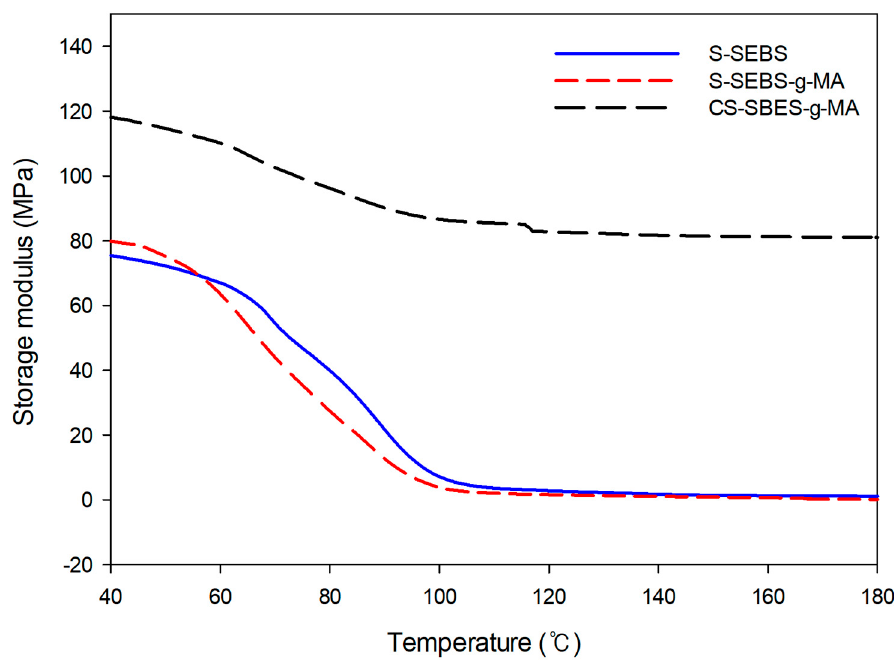
Figure 8. Storage modulus of the S-SEBS, S-SEBS-g-MA and cross-linked